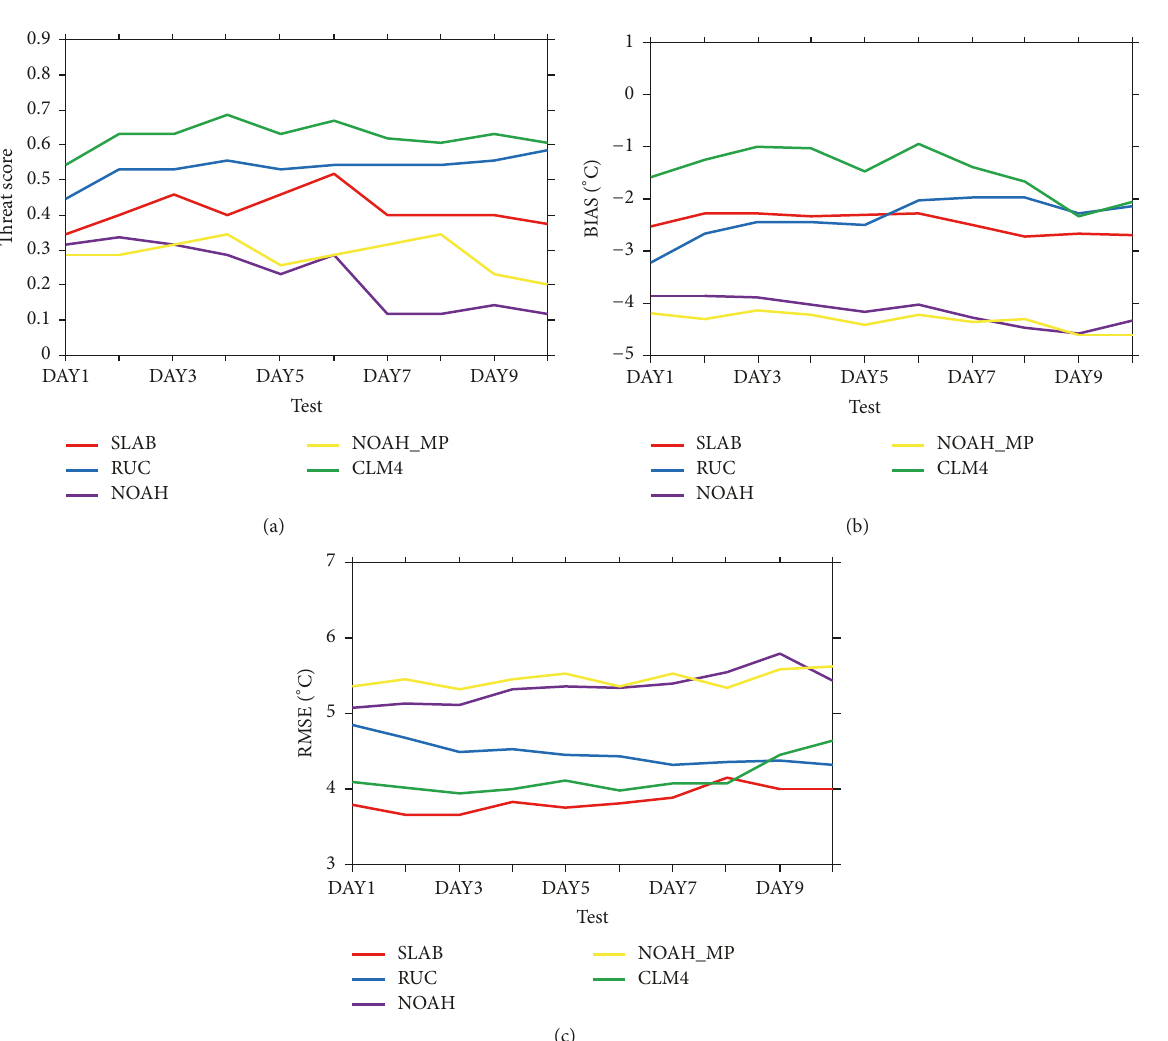
Figure 5: Assessment using the following measures: (a) TS, (b) BIAS, and (c)